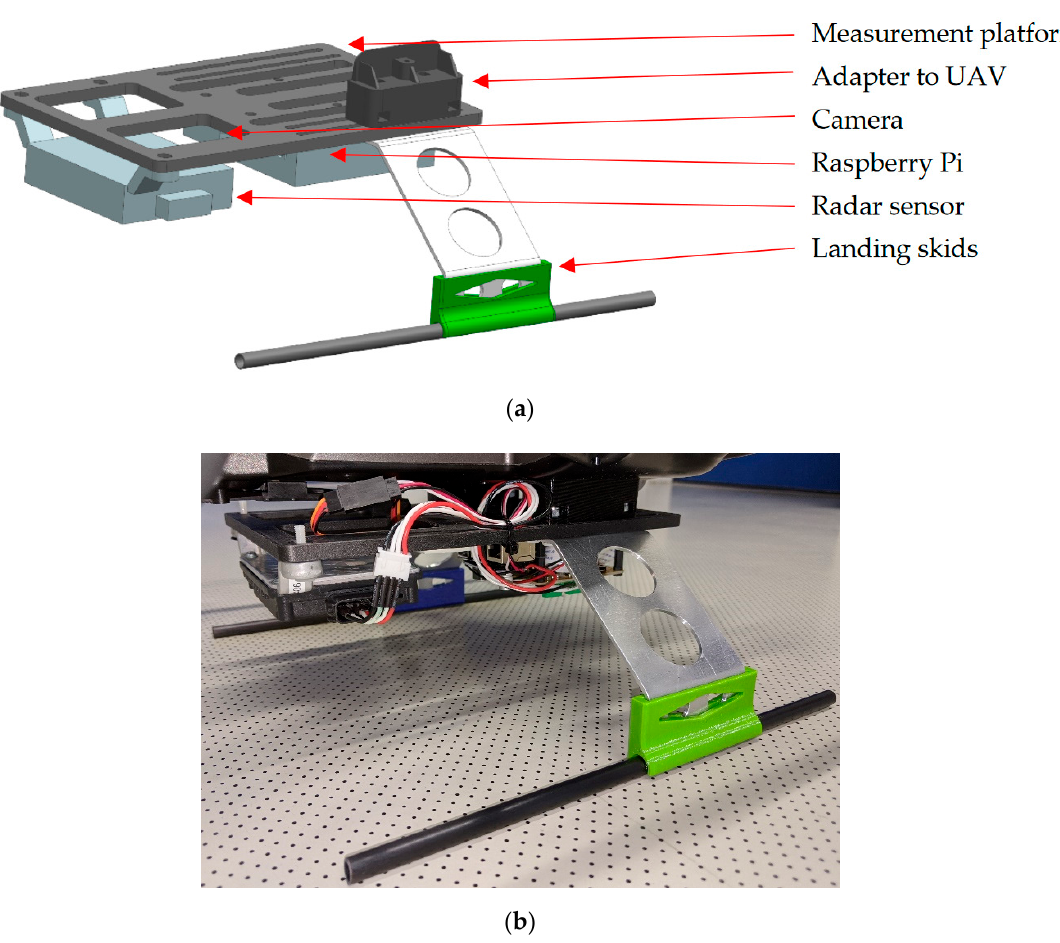
Figure 4. Construction of the bracket system. ( a ) Design of the frame to mount the measurement system and attach it to the unmanned aerial vehicles (UAVs). The adapter to the UAV and the landing skid is only one time shown; the other side is a mirrored copy. ( b ) Attached frame on the UAV. Sensors 2020 , 20 , x FOR PEER REVIEW